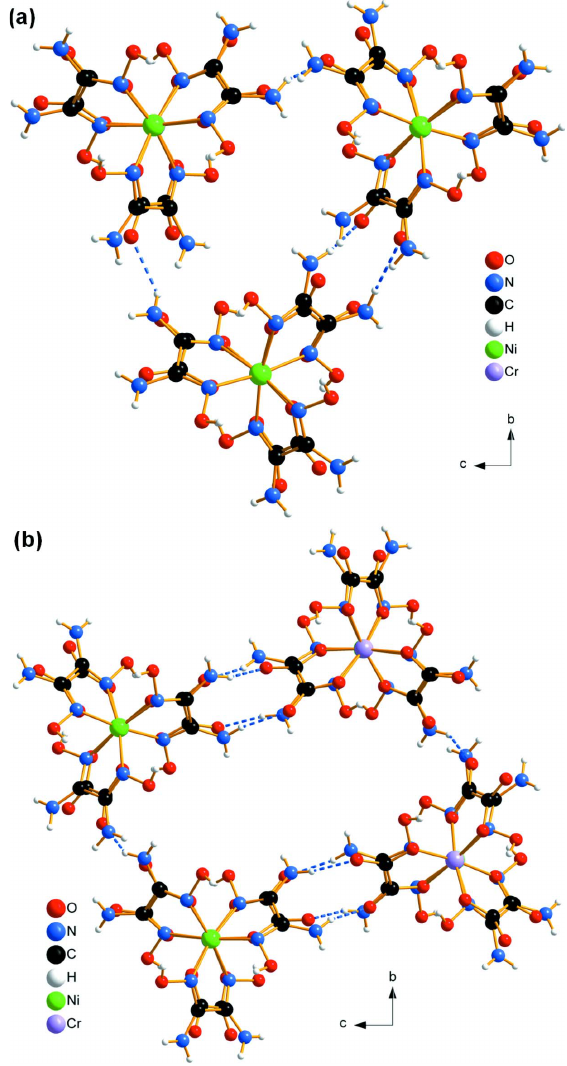
metal complexes are linked by intermolecular O—H (cid:2) (cid:2) (cid:2) O hydrogen bonds between three hydroxyl groups from the oxamide dioxime ligands as donor groups and three ligating O atoms from the oxalate ligands as acceptors. These inter- actions connect the metal complexes into pillars running parallel to the [100] direction (Fig. 1). Adjacent pillars are further linked to each other through intermolecular N— Figure 4 H (cid:2) (cid:2) (cid:2) O hydrogen bonds involving the amino groups from the The connection of three ( a ) and four ( b ) neighboring pillars through oxamide dioxime ligands as donor groups and the non-coor- hydrogen bonds (dashed lines) in the structure of ( I ). 1734 Mbiangue´ et al. (cid:3) (NH 4 ) 2 [Ni(C 2 H 6 N 4 O 3 ) 3 ][Cr(C 2 O 4 ) 3 ] (cid:2) 6.76H 2 O Acta Cryst. (2020). E 76 , 1732–1736